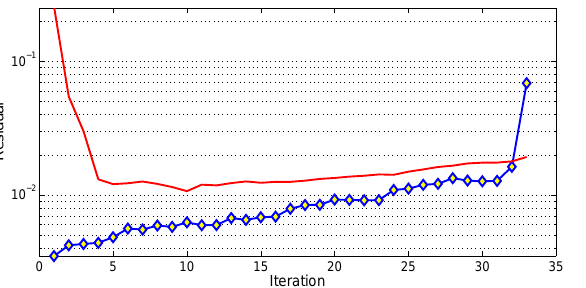
Figure 2: The ( s + 1) th residual (diamonds) and the value of the threshold ( t σ s ) (red line) at each iteration of FS. (1 − α/ 2( s +1) ,s − k )